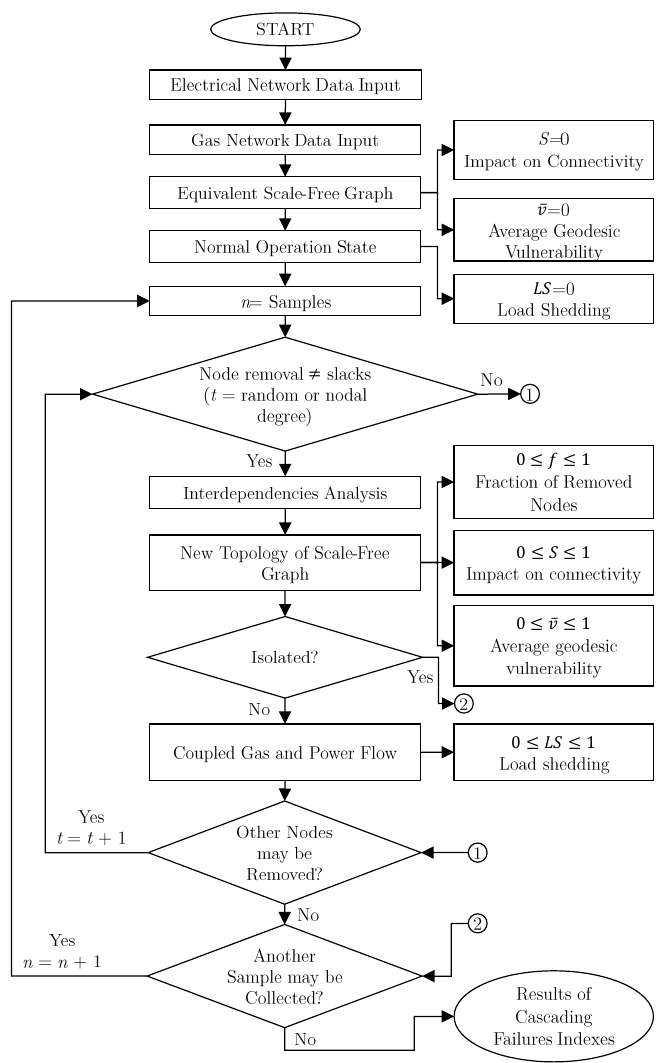
Figure 4. Flow chart for the algorithm to evaluate the structural vulnerability against cascading failures in coupled electric power and gas